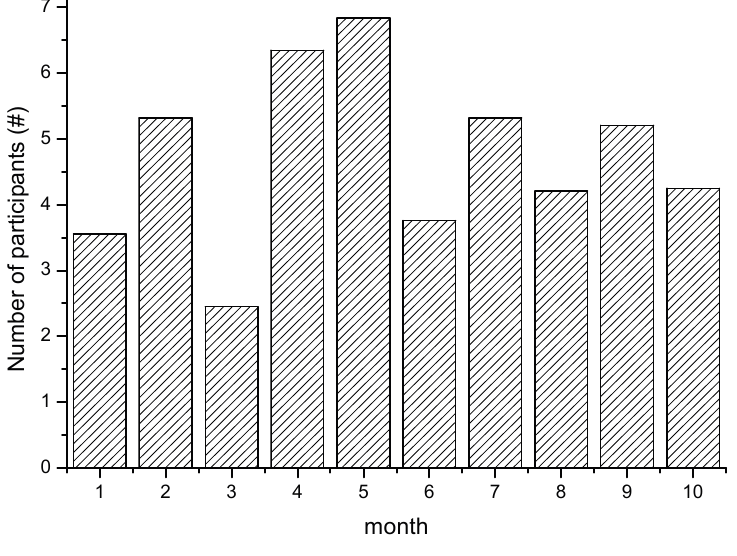
Figure 7. The self-adaptive participant number.